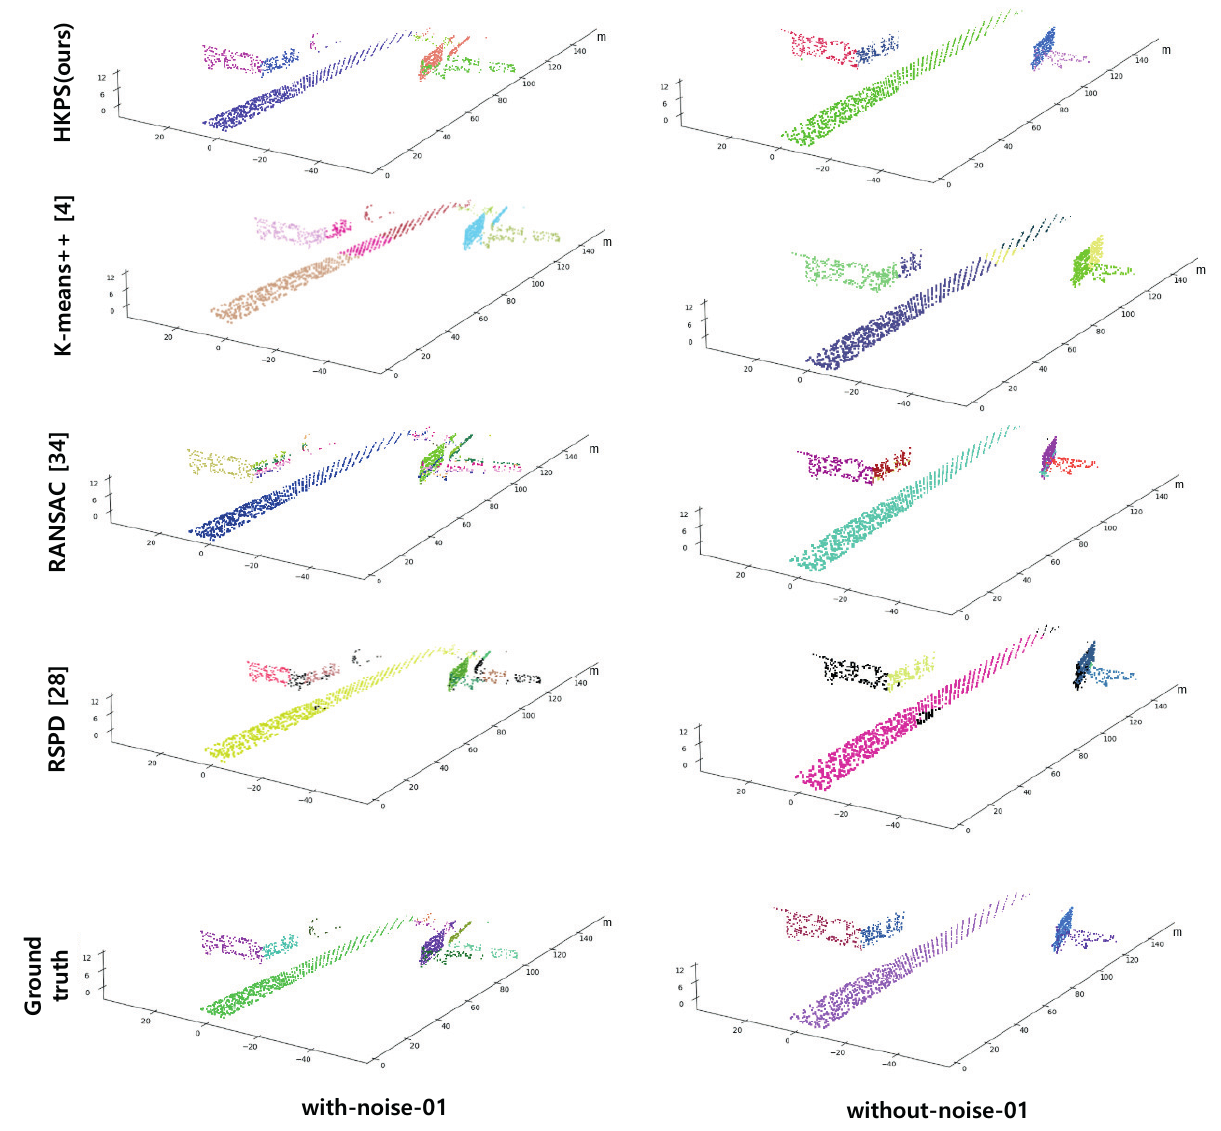
Figure 5. Performance comparison results using scene 01 from with-noise Virtual KITTI Dataset and without-noise Virtual KITTI Dataset. Different planes are displayed with different colors. The outliers of RANSAC and RSPD are colored in